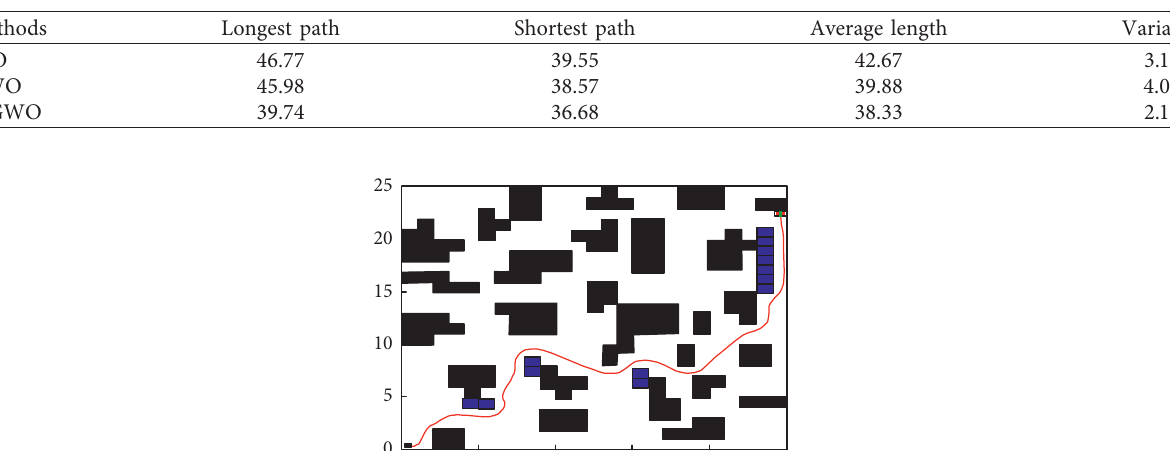
Table 4: Quantification results.